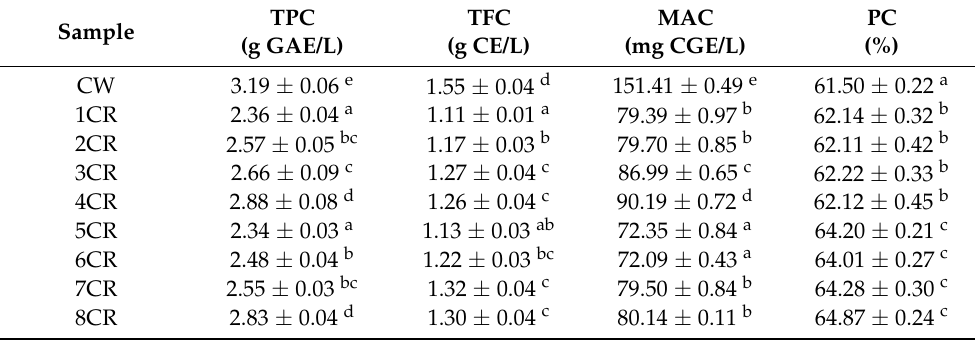
Table 3. Phenolic compounds content of initial conventional Cabernet Sauvignon red wine and retentates obtained by reverse osmosis at 2.5, 3.5, 4.5, and 5.5 MPa with cooling and without cooling. Sample